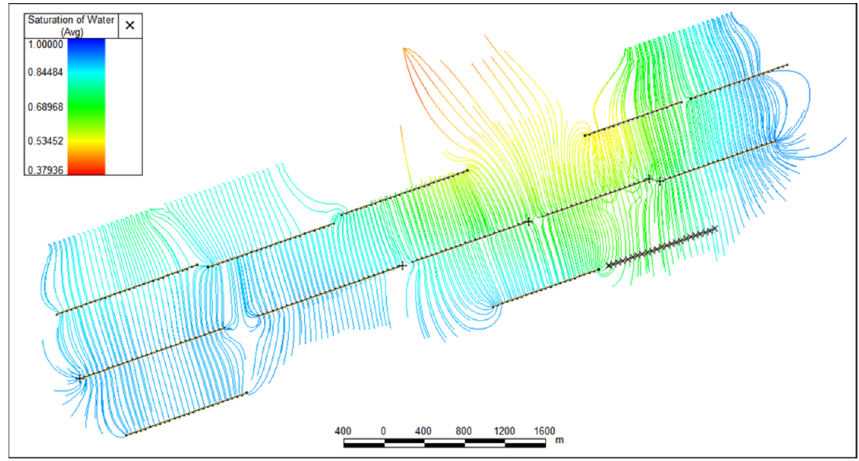
Figure 24. Streamline diagram of injection ‐ production horizontal well pattern.